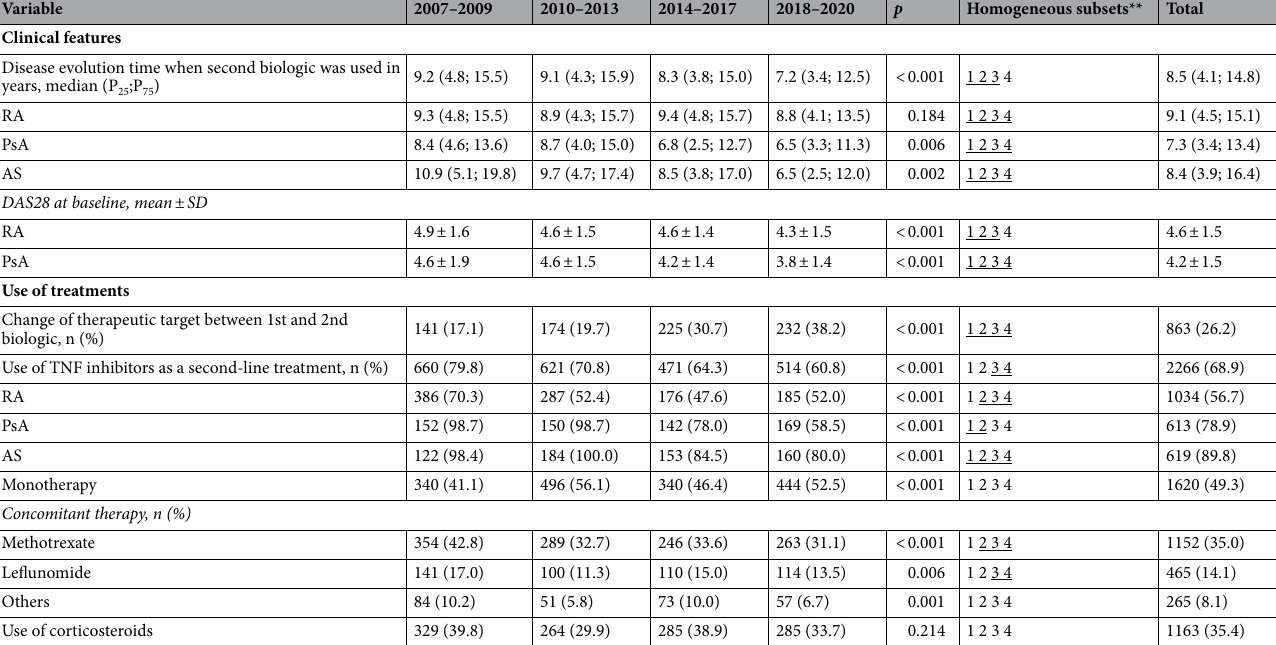
Table 4. Clinical features and use of treatments at the beginning of a second biologic (second-line treatment) by time period. *Centers that included at least one patient in this analysis. **The homogeneous subsets are represented by lines joining the time periods in which differences were not statistically